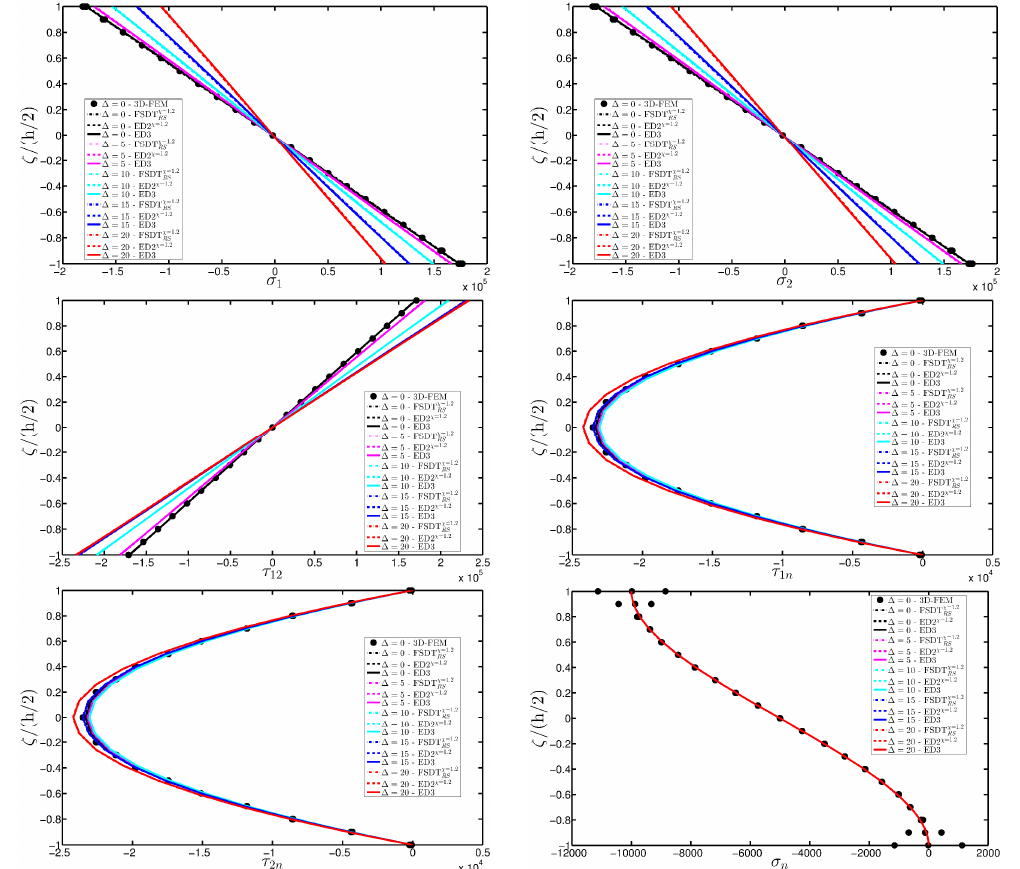
Figure 11. Through-the-thickness profiles of stress components [Pa] for the CCCC isotropic square plate computed at the point A for different HSDTs. The effect of the damage is investigated by varying the parameters of the function Gau-3.